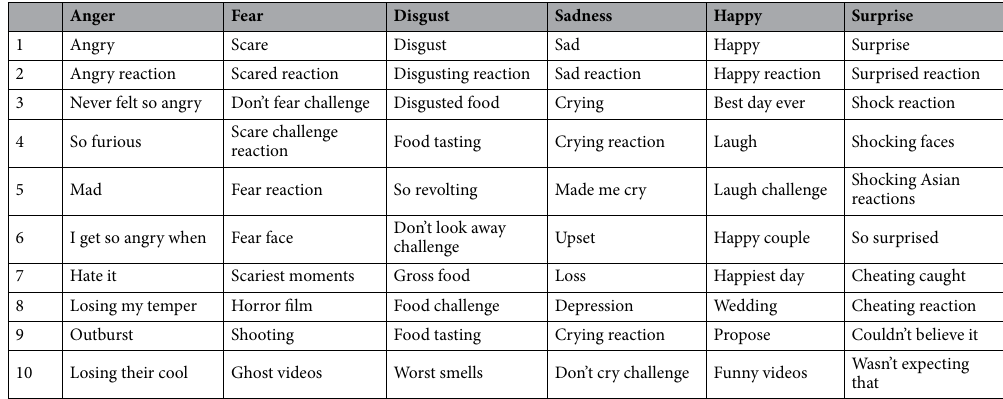
Table 1. Examples of WFD stimuli search